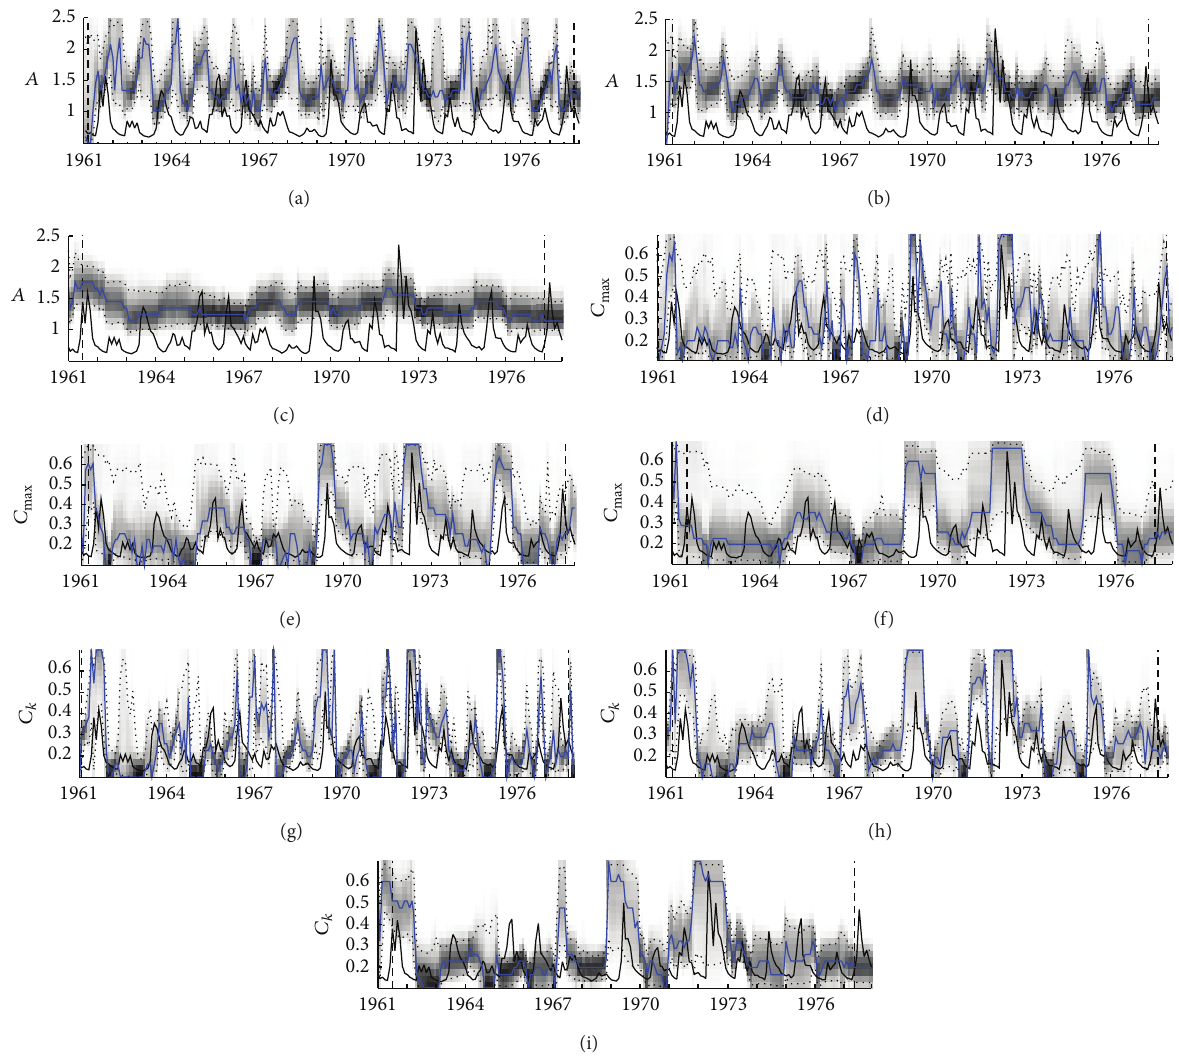
Figure 3: Dynamic Identifiability Analysis plots for the RMSE OF and for 3, 7, and 13 months and for parameters 𝐴 (plots a, b, and c, resp.), 𝐶 𝐶 max (plots d, e, and f, resp.), and 𝑘 (plots g, h, and I, resp.). The dashed lines show the 5 and 95% confidence limits, the black lines show the relative time-series of the streamflow data, and the blue lines show the time-series of highest identifiability for each time-window